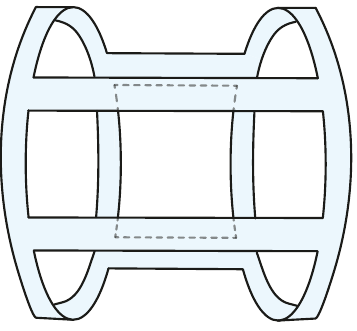
(cid:0) (cid:1) h R, R | ⊗ h R, R | | ρ, σ i for n = 2 and the con-